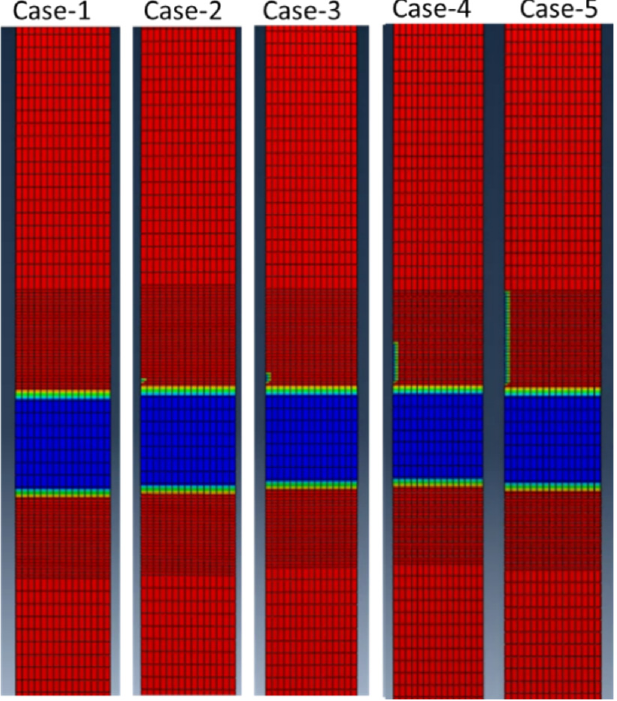
Figure 9. Crack propagation plot for the different applied loading conditions.